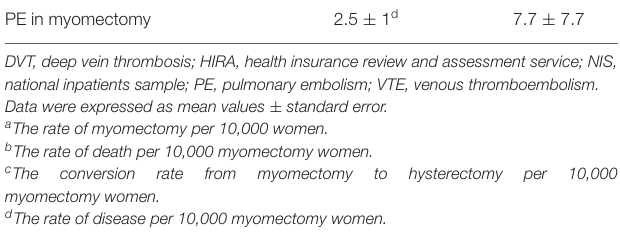
Rate or Estimated